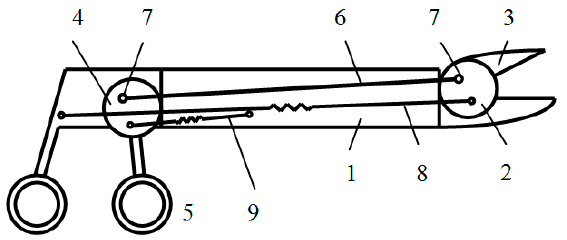
Figure 1. Mechanical model of the laparoscopic grasper